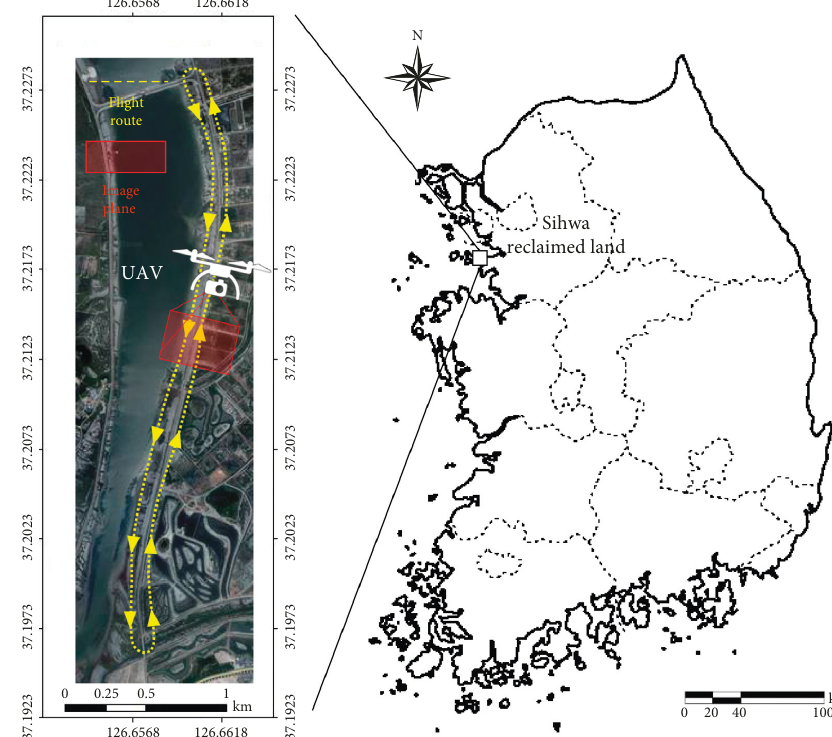
Figure 1: Location of the study area and the flight path of the